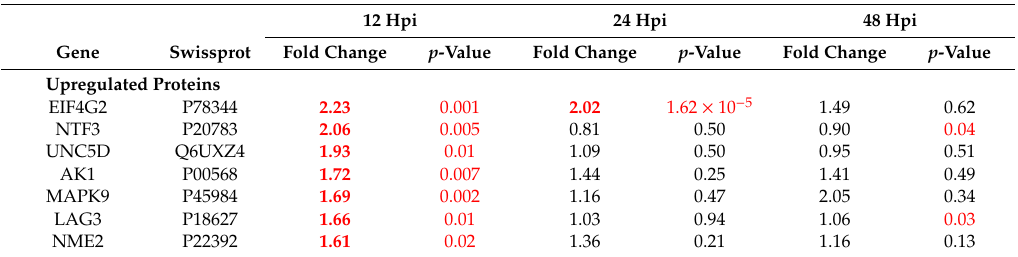
Table 2. List of significantly dysregulated Caco-2 proteins after ZIKV